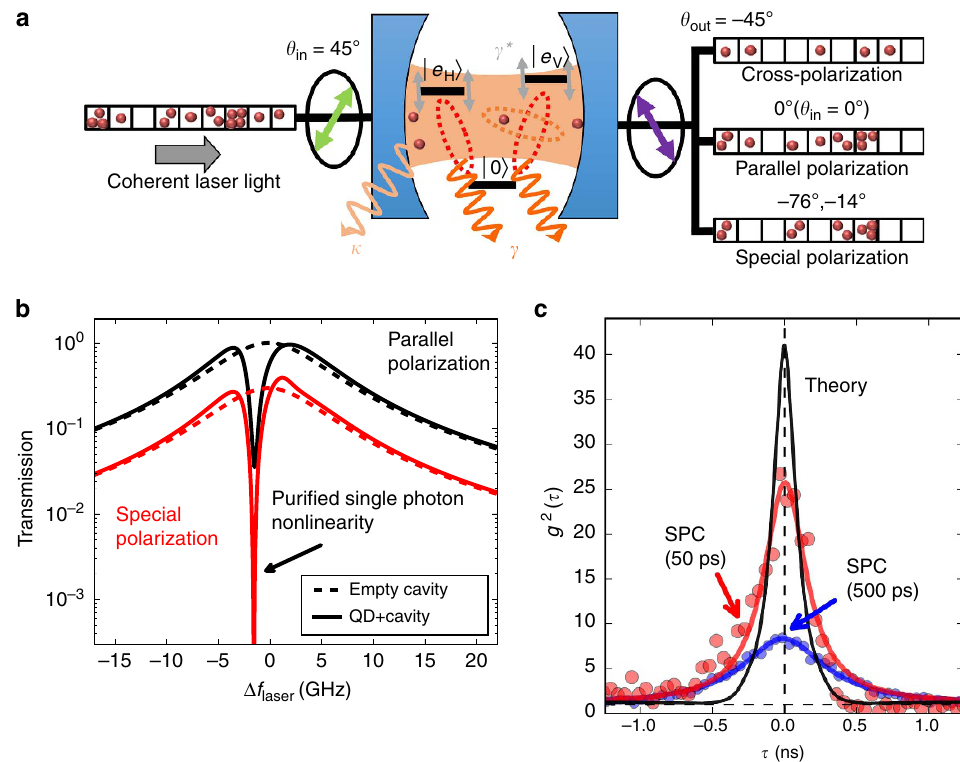
Figure 1 | The purification technique. ( a ) Cartoon of the experiment: polarization pre- and postselection in a resonant transmission CQED experiment enables tuning of the photon statistics from antibunched to bunched. ( b ) Theoretical resonant transmission spectra for coherent light with mean photon number oo 1, with and without the QD, comparing the conventional case (parallel polarizers) with the case of special polarization postselection along y (cid:3) close to one of the QD resonances, single-photon transmission is perfectly suppressed, despite the finite lifetime and cavity coupling of the QD transition. ( c ) Second-order correlation function for the special polarization angle case, comparing theory and experiment using two different sets of single photon counters (SPCs) with different timing jitter, 50ps and